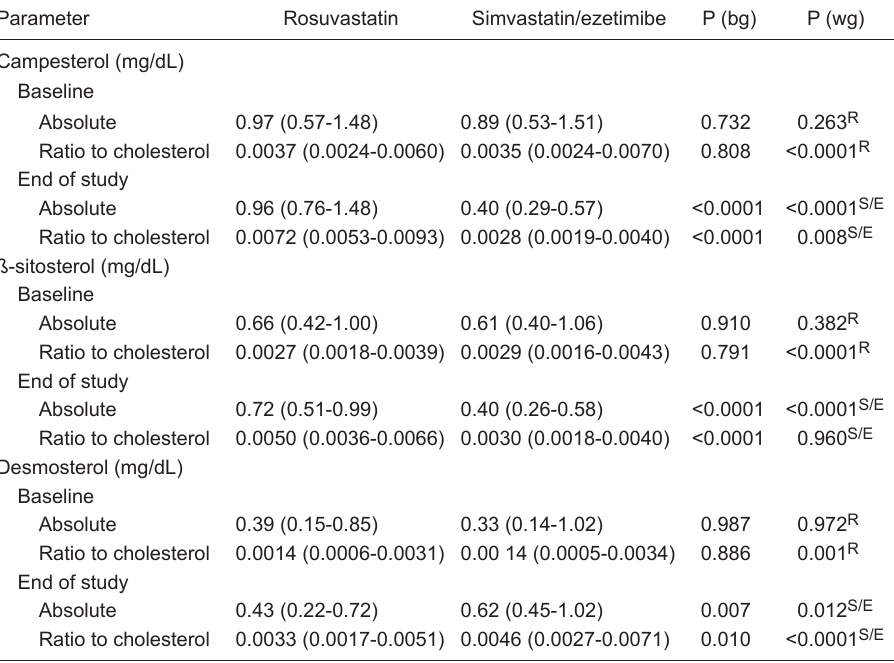
Table 4. Markers of cholesterol absorption and synthesis and their ratios to cholesterol by groups at baseline and at the end of the